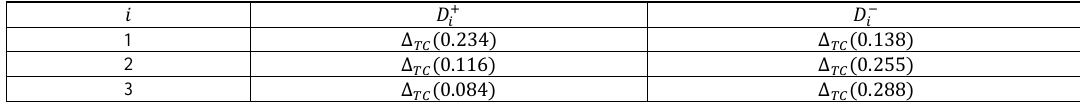
Table 4. Separation measures from Positive ideal solution and Negative ideal solution of three robots for evaluations given in Table 2 using the suggested distance measure 𝑖 𝐷 𝑖+ 𝐷 𝑖−